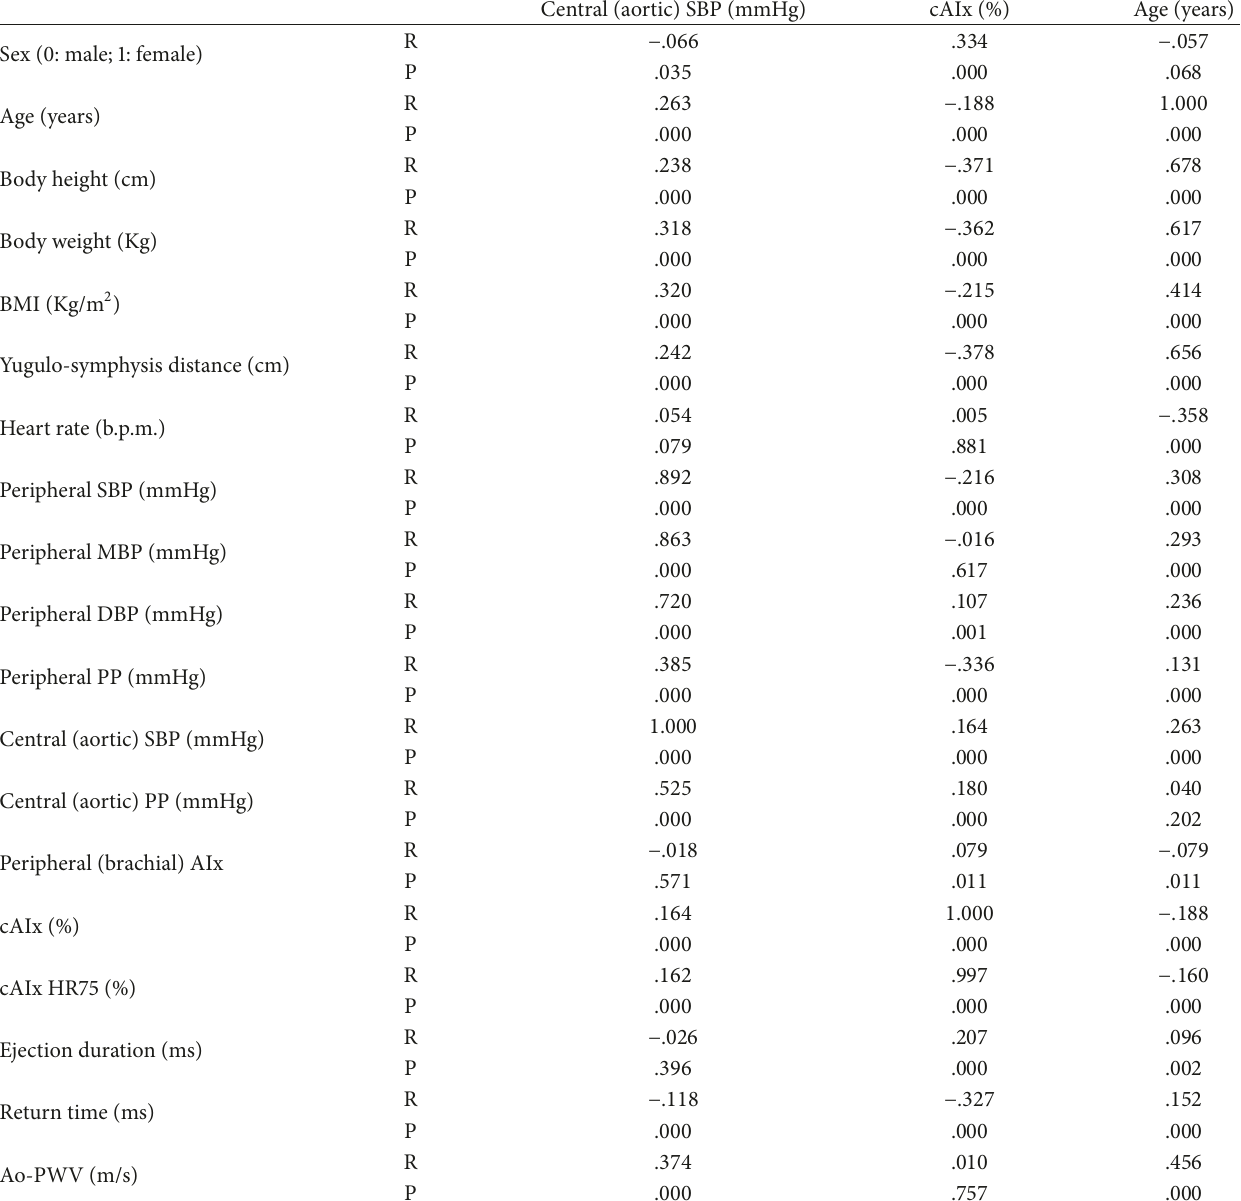
Table 2: Association between aortic characteristics and anthropometric and haemodynamic